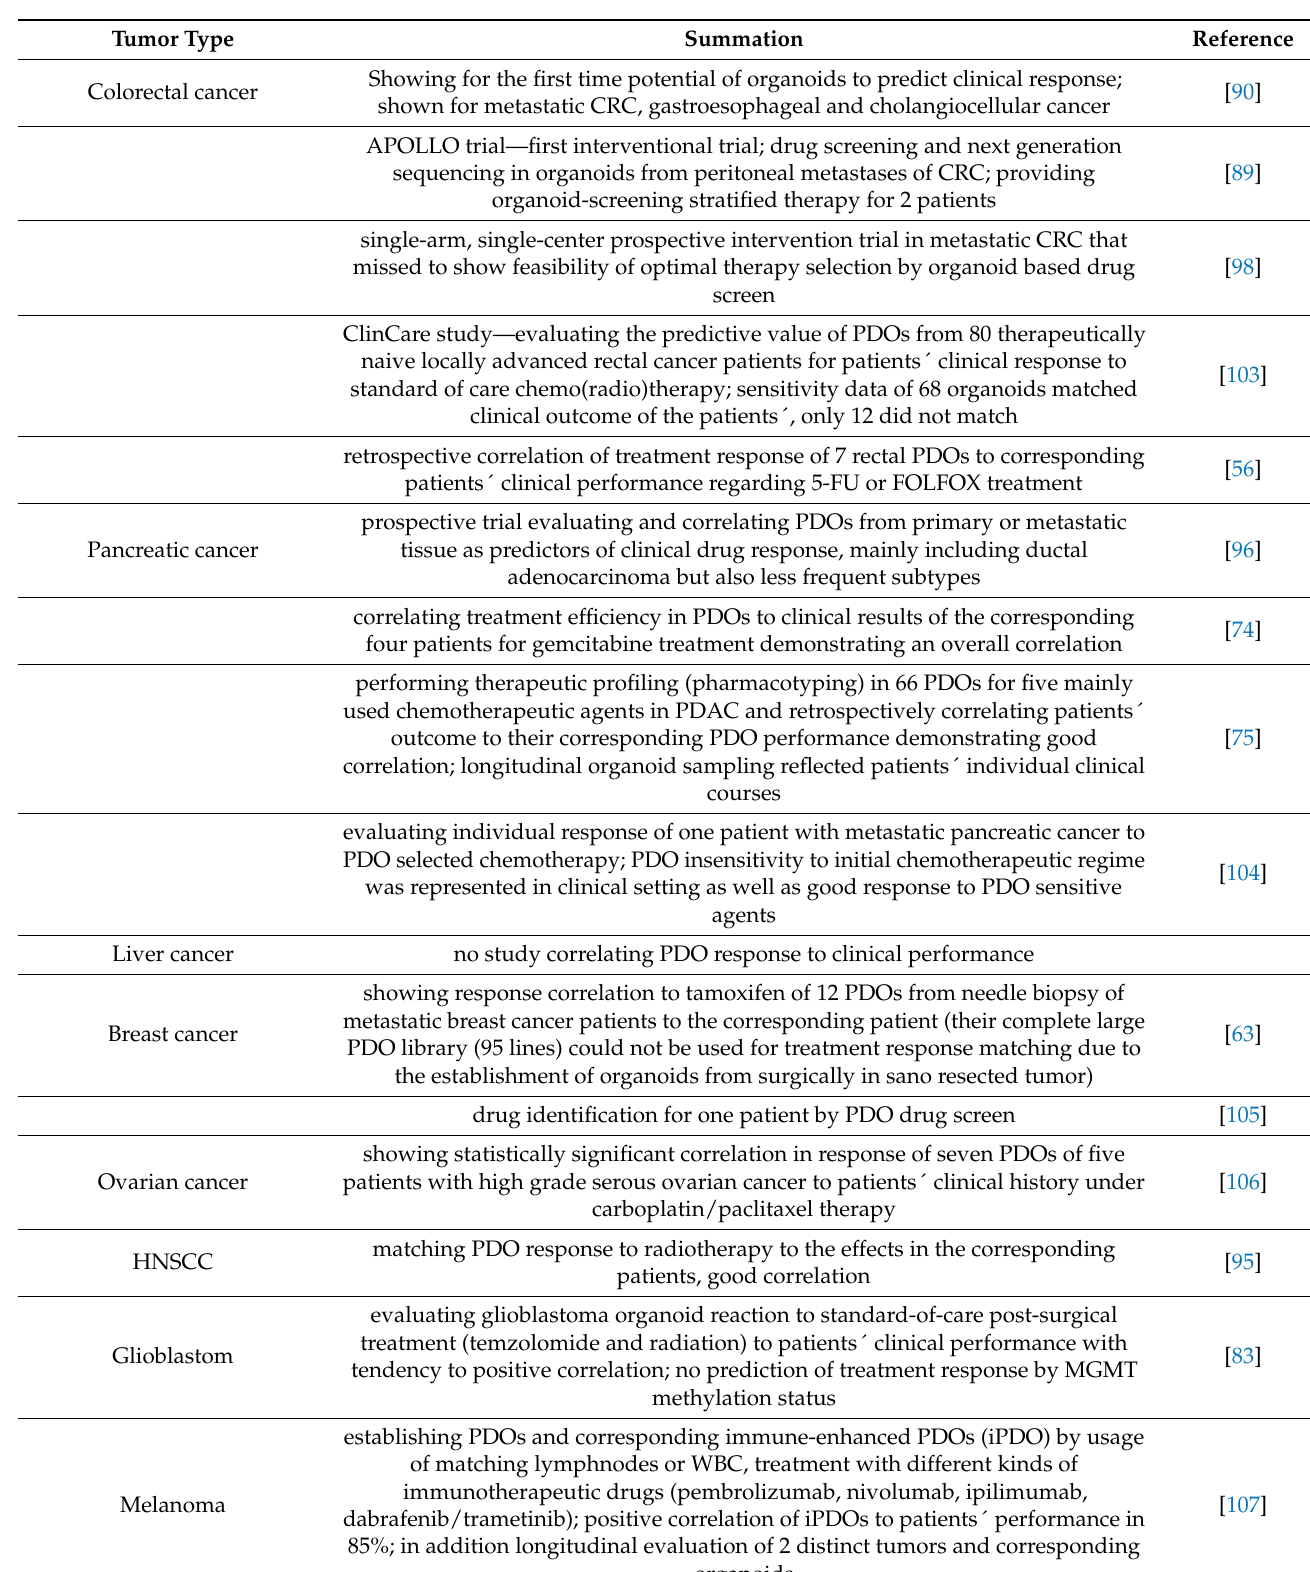
Table 2 Selected studies dealing with feasibility of therapy response prediction and selection of patients ´ optimal therapy based on PDO drug testing, i.a.